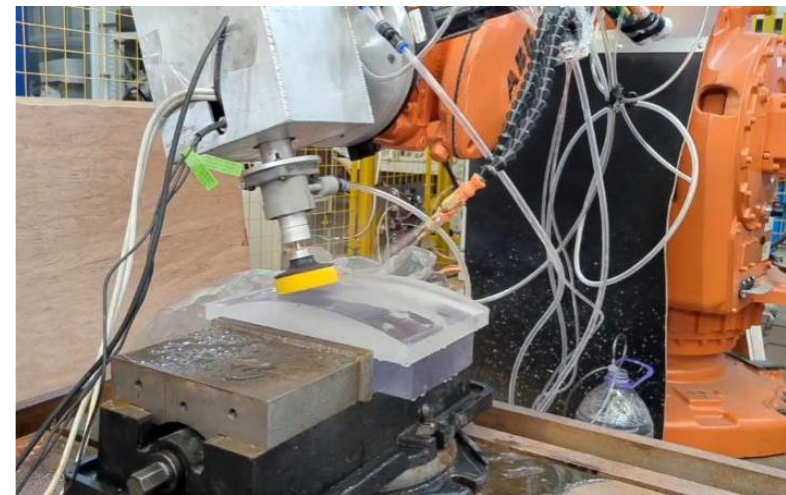
Figure 11. Polishing process of the complex curved plexiglass part.